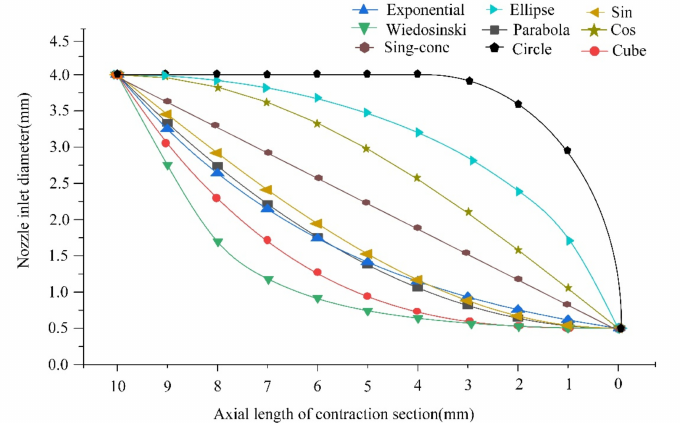
Figure 7. Section curve of nozzle contraction